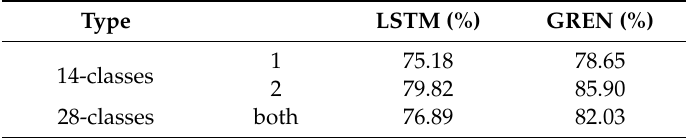
Table 2. Comparison results between long short-term memory (LSTM) and gesture recognition using an enhanced network (GREN) networks based on the DHGD dataset.